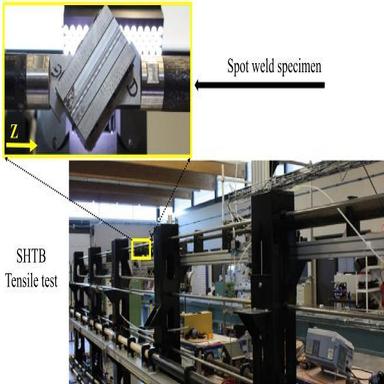
Split Hopkinson Tension Bars set-up for testing of spot-welded specimens under dynamic loading conditions.